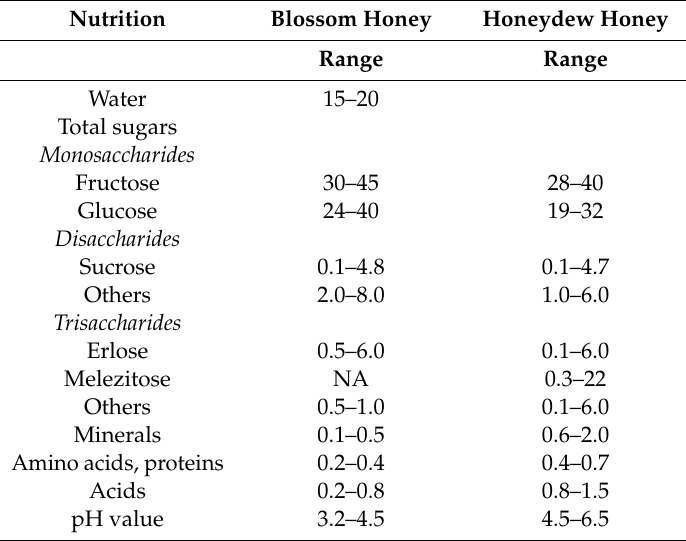
Table 3. Nutritional composition of pure